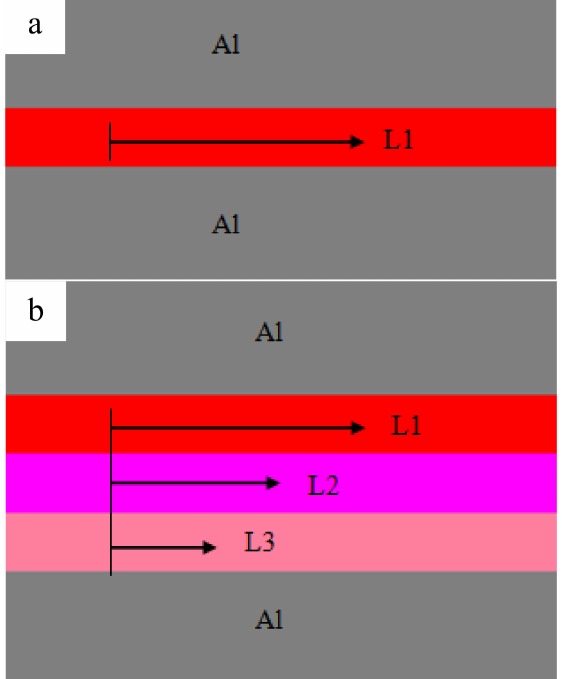
Figure 9. Schematic of the vibration amplitude of the Al 2219 particles in the joints with different interlayer thicknesses: ( a ) 10 µ m and ( b ) 30 µ m. (The 10- µ m thickness interlayer is equivalently composed of a layer of Al 2219 particles, and the 30- µ m interlayer thickness equivalently consists of three layers of Al 2219